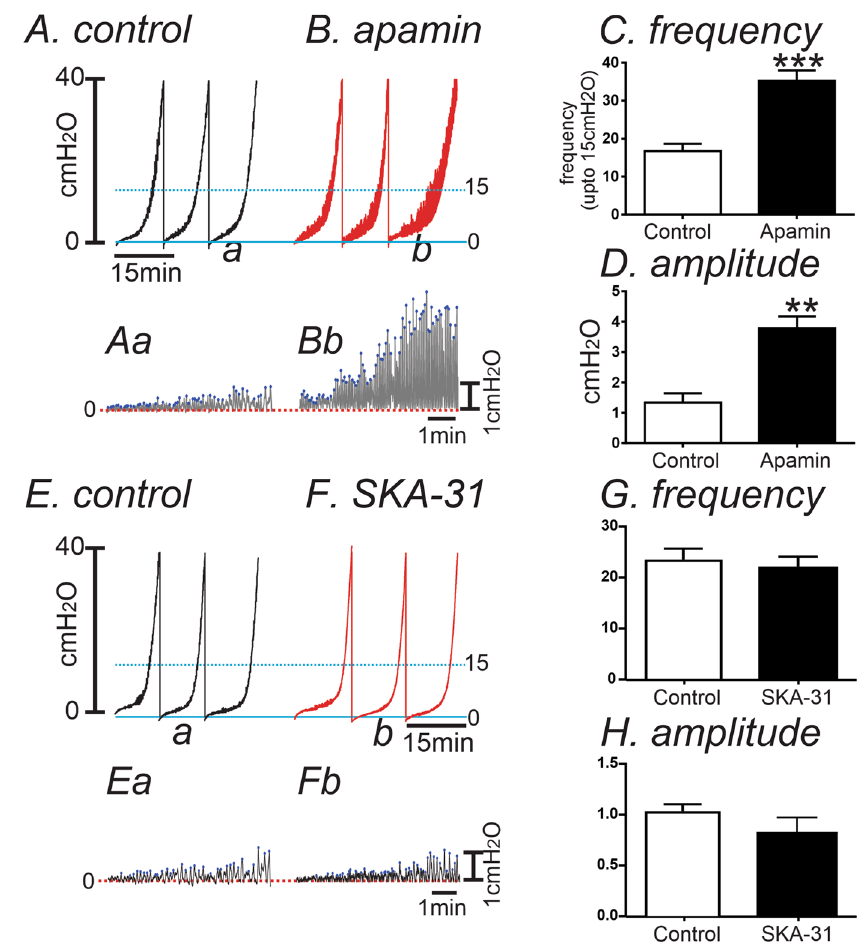
Figure 6. The Effect of SK channel blocker on spontaneous activity using the ex vivo volume-pressure relationship in control bladders. ( A,B ) Ex vivo compliance curves for control ( A ) and after apamin application ( B ) from control bladders up to 15 cmH 2 O (see blue dotted line). Expanded time scales with adjustment of baseline under control ( Aa ) and apamin ( Bb ) from panel ( A,B ) respectively. Blue dots were detected